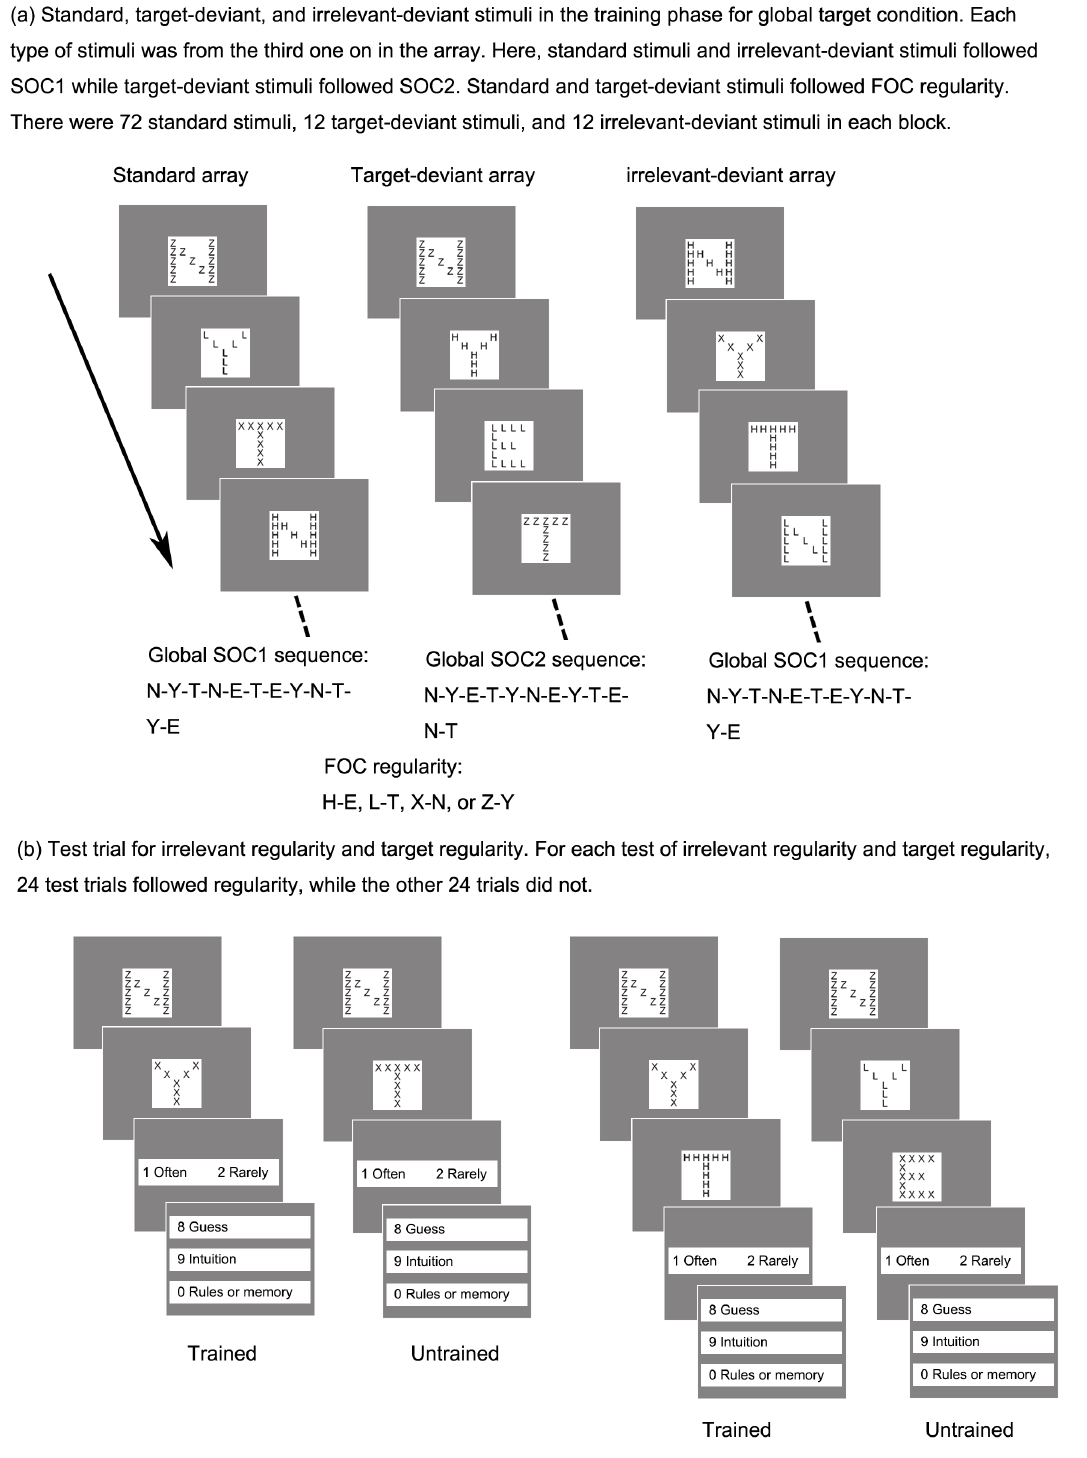
Figure 2. Experimental setup and design.